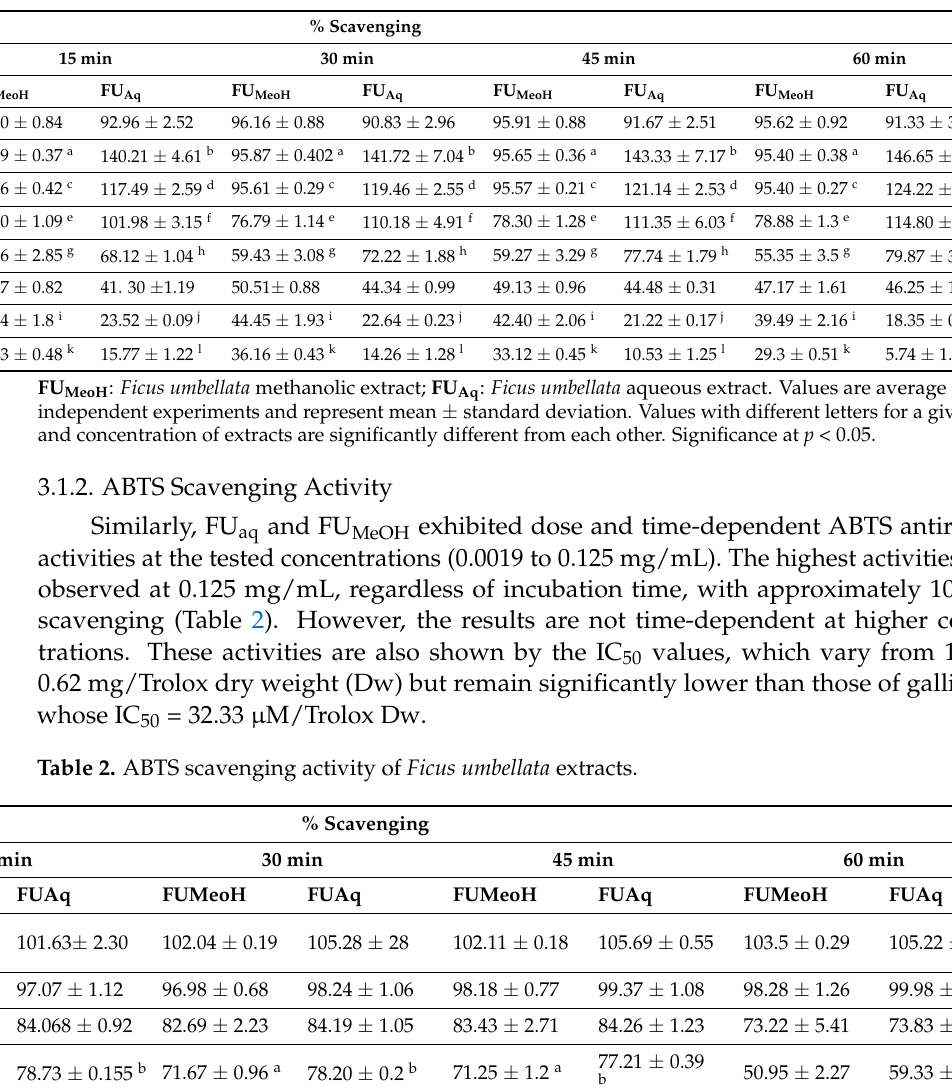
Table 1. DPPH scavenging activity of F. umbellatta extracts.